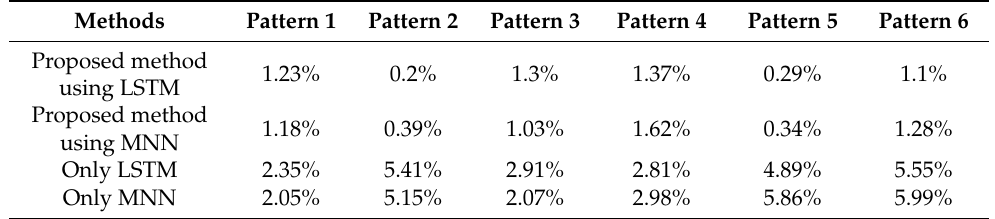
Table 6. The SOC estimation error for each model when four voltage parameters were input.